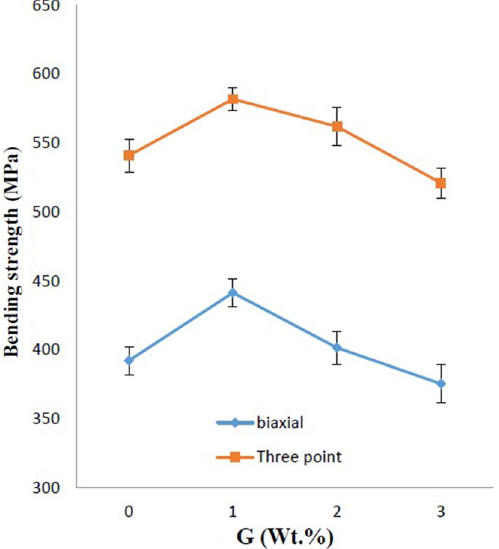
Figure 9. Comparison of three-point bending strength and biaxial bending